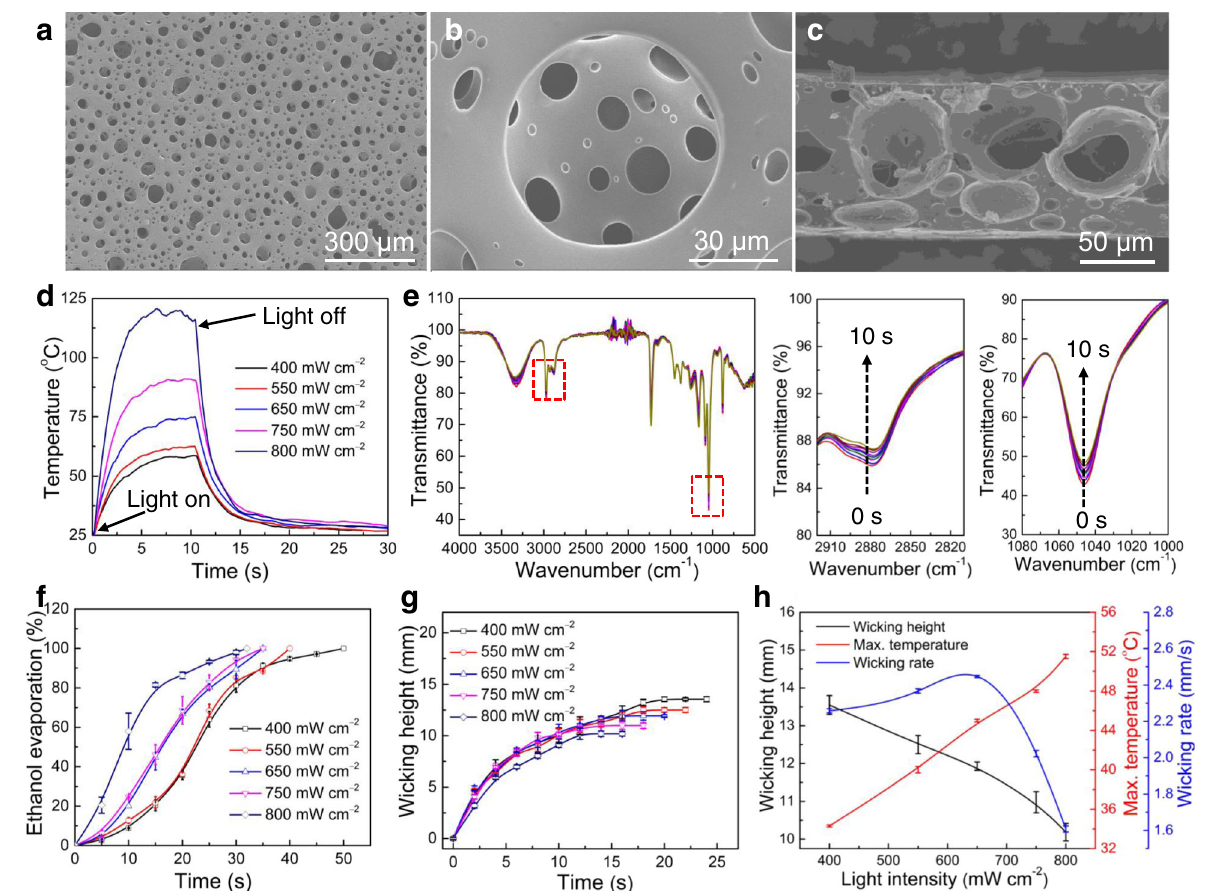
Fig.2|CharacterizationsofthePP/CBporous fi lm.a , b Topviewand c sideview of the porous PP/CB fi lm used for the oscillating actuator. d Maximum surface temperature as a function of time for the dry porous PP/CB fi lm obtained by switching infrared light with different light intensities on and off. e Fourier trans- form infrared (FTIR) spectra of the porous PP/CB fi lm in fi ltrated with ethanol exposed to air for different times. The panels to the right show magni fi ed images